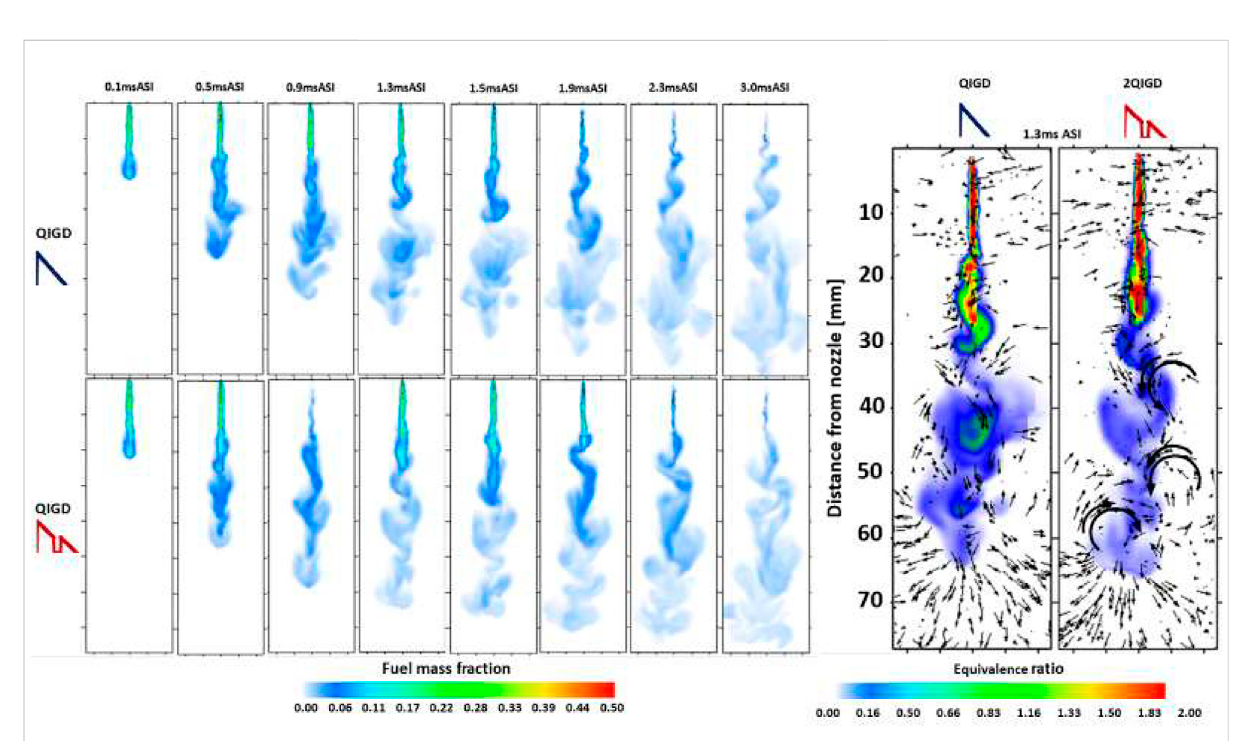
FIGURE 12 Fuel mass fraction history, equivalence ratio history, and velocity vector of QIGD and